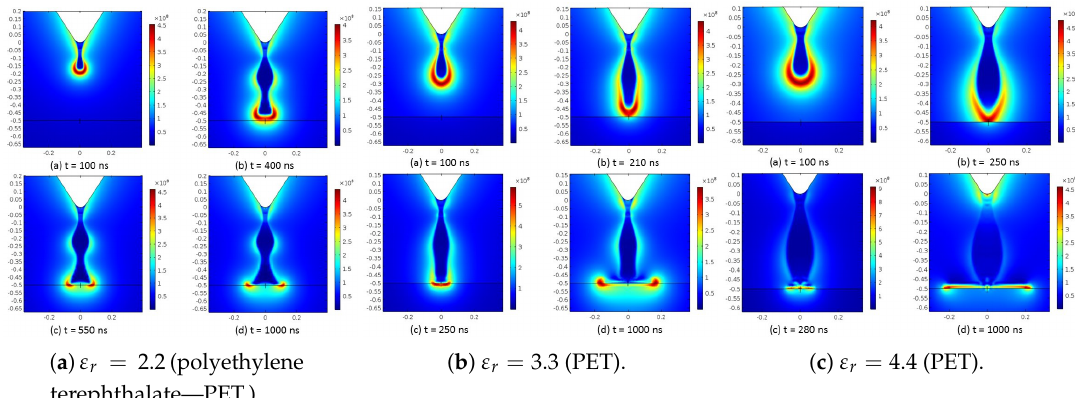
Figure 9. Positive streamer propagation. Evolution of the electric field (V/m) in mineral oil transformed with a horizontal solid barrier with ( a ) ε r = 2.2 (polytetrafluoroethylene—PTFE), ( b ) ε r = 3.3 (PTFE), and ( c ) ε r = 4.4 (PTFE), applying 300 kV and with a rise time of 10